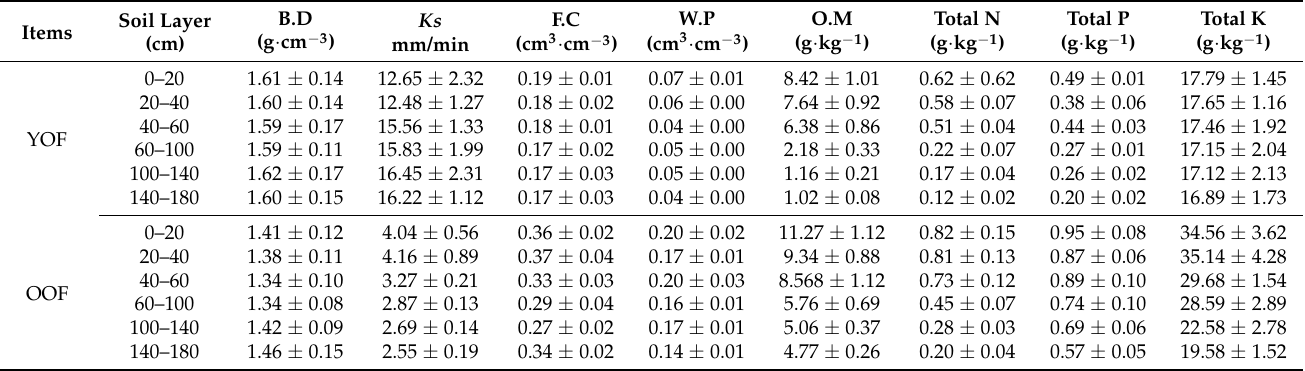
Table 1. Soil physical and chemical properties in a young oasis field (YOF) and old oasis field (OOF). Averages are based on three replicates.